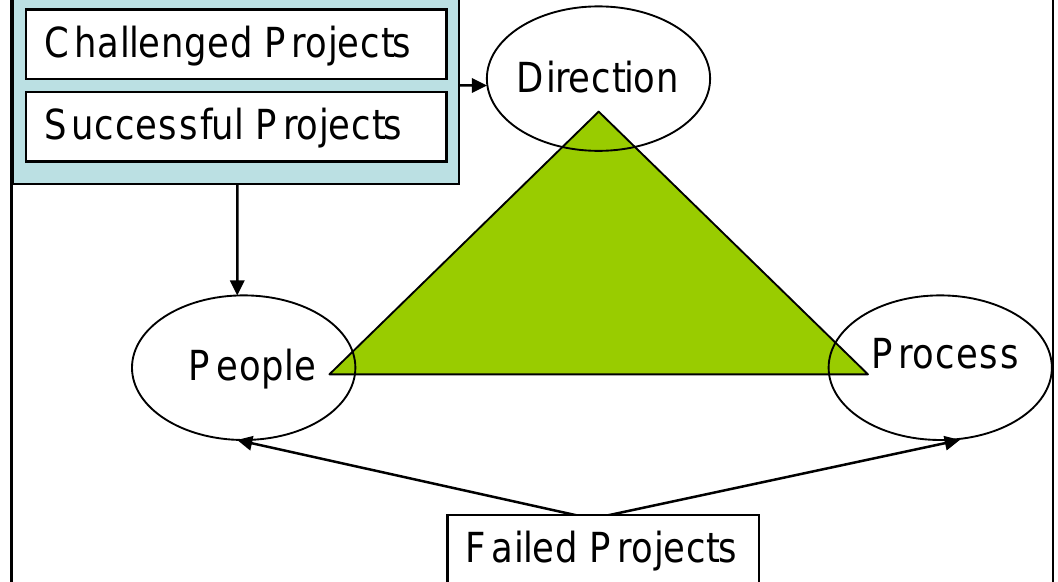
Figure 6: Relationship between themes and project